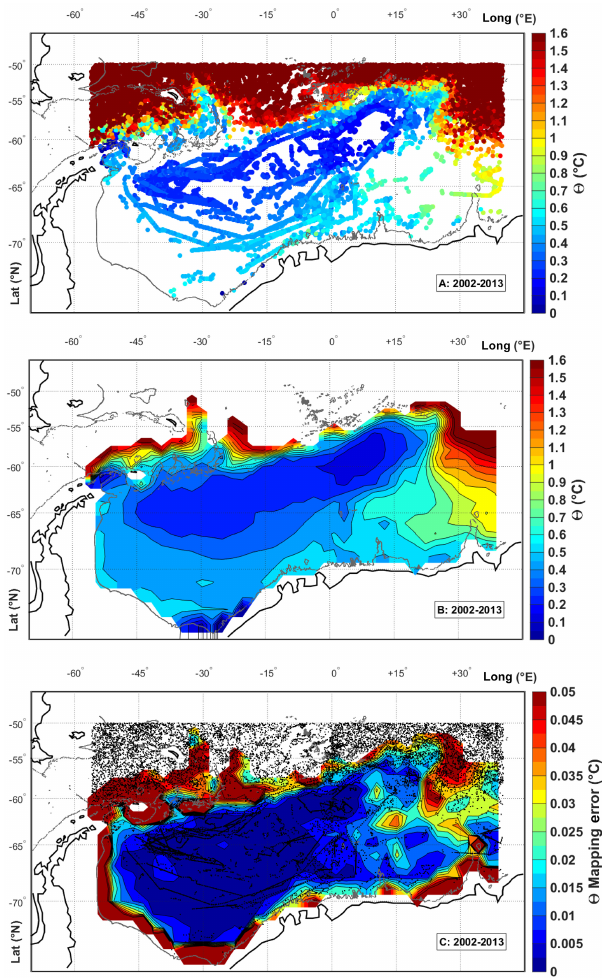
Figure 22. Absolute salinity (gkg − 1 ) at 800dbar for the entire time period, where panel (a) shows the original float data, panel (b) shows the objectively mapped field and panel (c) shows the mapping error for the mapped field (profile locations are marked as black dots). The grey contour shows the 2000m